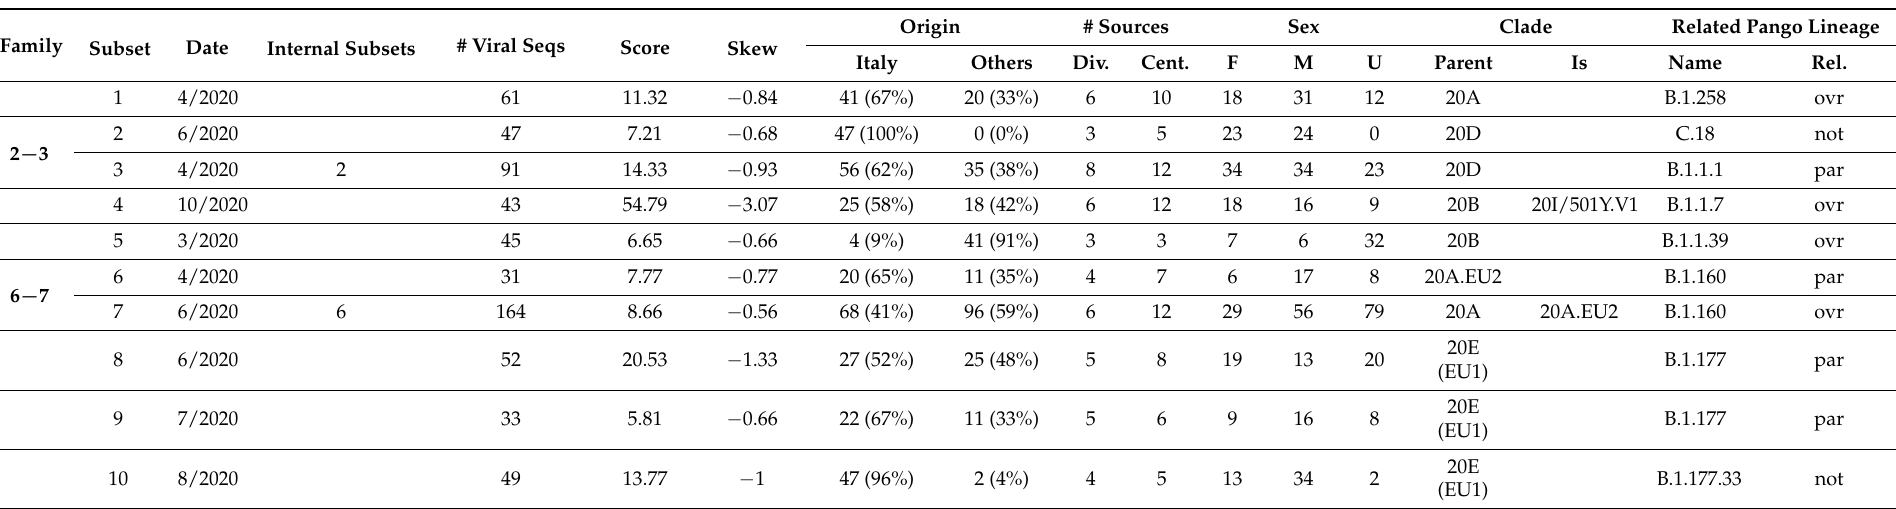
Table 1. Annotated list of growing subsets identified in the 2020